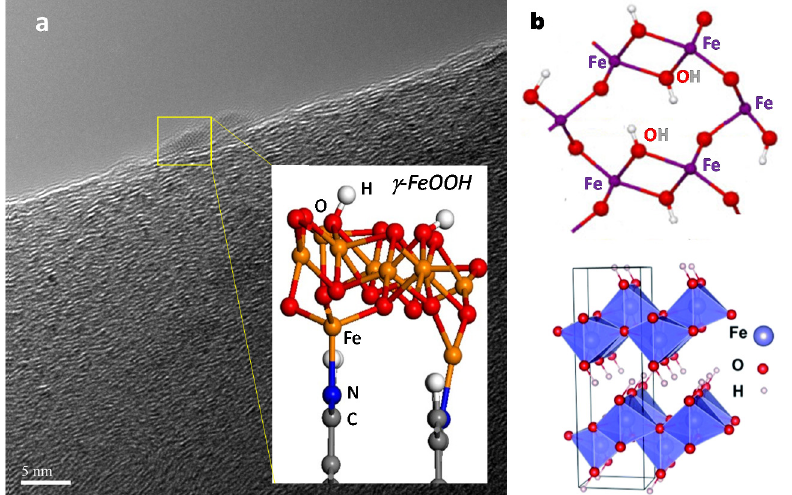
Figure 6. ( a ) High-resolution transmission electron microscopy (HRTEM) of activated iron-oxide/carbon nanotube (CNT) electrocatalysts for N 2 reduction reaction (NRR) (adapted from [79]), with the inset reporting a lateral view of the optimized ferrihydrite nanostructures decorating the N-doped graphitic zigzag edges (adapted from [78]. Copyright 2018 Springer Nature). ( b ) Proposed γ -FeOOH (bottom) nanostructure and related surface structure (top) for simultaneous multi-electron and -proton transfer in NRR and CO 2 RR (for the latter, to >C1 products). Adapted from [31]. Copyright 2019 Elsevier.